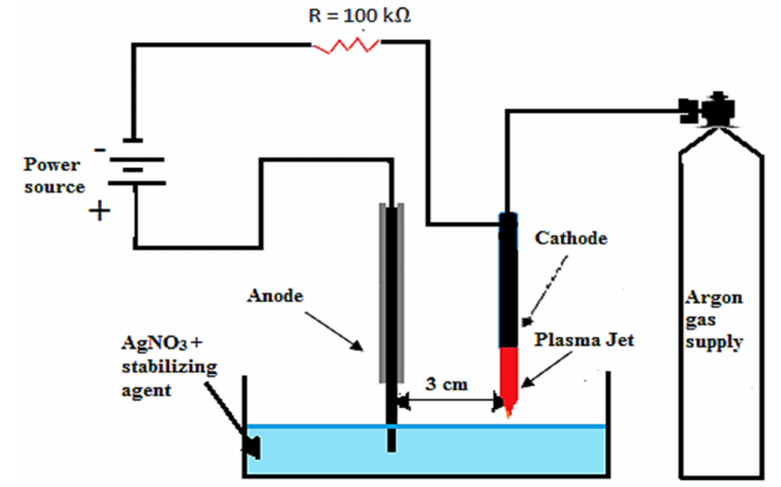
Figure 1. Schematic diagram of plasma synthesized